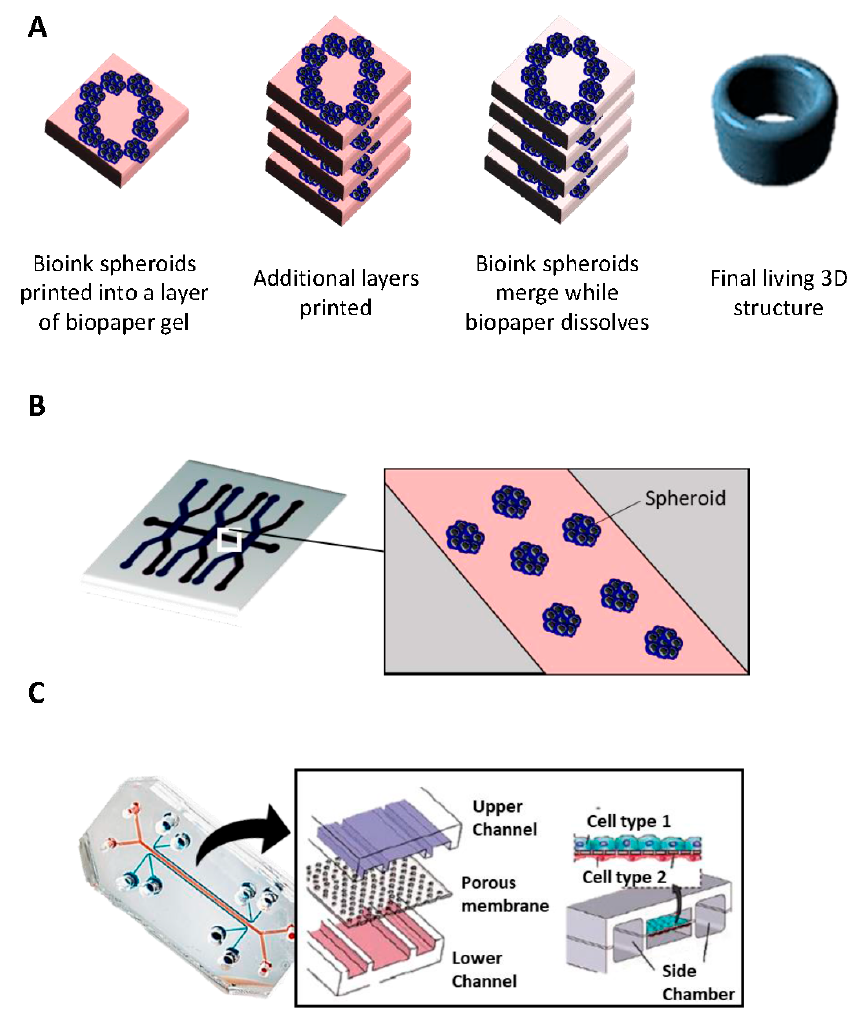
Figure 2. Bioprinting and Microfluidic platforms. ( A ) Biopaper gel is loaded with bioink spheroids that each contain an aggregate of a few thousand cells. More layers are subsequently added and as the biopaper gel dissolves, and the bioink spheroids slowly fuse together, leaving a final bioprinted structure. ( B ) An example of simple microfluidics system in which cancer spheroids were embedded in micro-patterned three-dimensional matrices immediately contiguous to a microchannel. ( C ) Schematic represents a two-chamber chip for the culture of two different cell types as monolayers in separate chambers that are linked through a porous membrane.